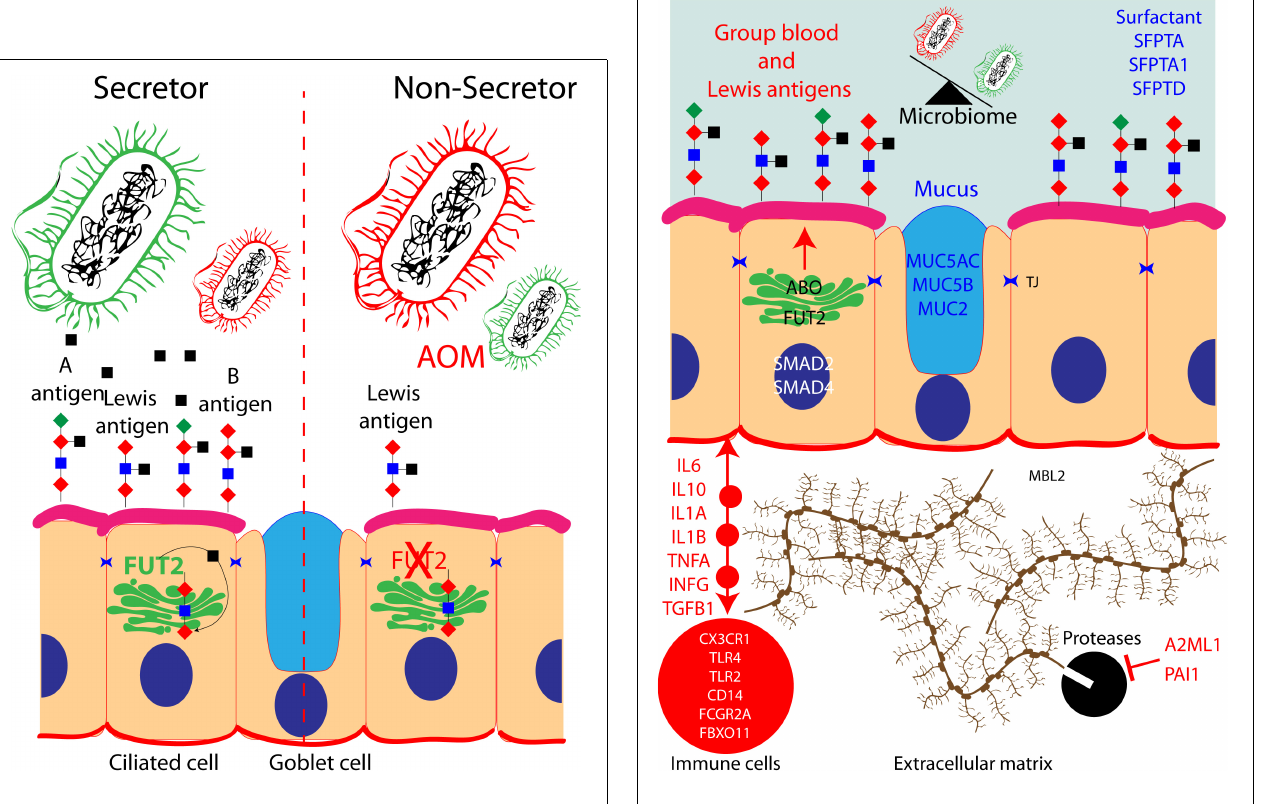
FIGURE 1 | Role of FUT2 in the regulation of blood group and Lewis antigens at the surface of ciliated cells of the middle ear mucosa: secretor and non-secretor status are illustrated. The imbalance of optimal bacteria (green) and pathogenic bacteria (red) is shown in a non-secretor individual that is prone to acute otitis media.